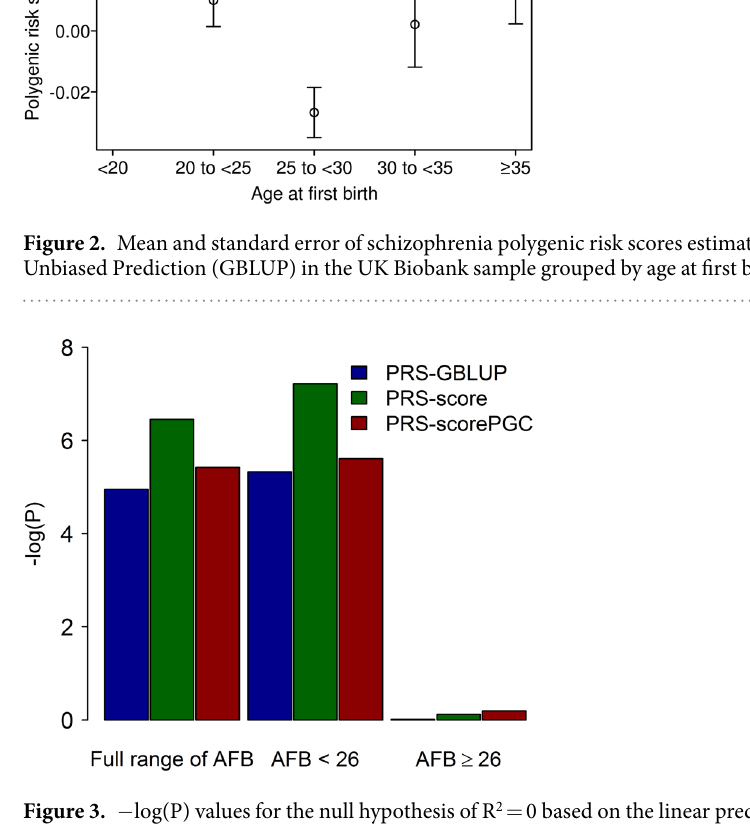
Figure 3. − log(P) values for the null hypothesis of R 2 = 0 based on the linear prediction. Full range of AFB: All available samples with a record of age at first birth were used. AFB < 26 ( ≥ 26): Analyses were only focus on samples with AFB < 26 ( ≥ 26). PRS-GBLUP: Schizophrenia (SCZ) polygenic risk scores estimated from genomic best linear unbiased prediction were used as an explanatory variable in the model. PRS-score: SCZ polygenic risk scores estimated from genome-wide association study based on available individual genotype data were used as an explanatory variable in the model. PRS-scorePGC: SCZ polygenic risk scores estimated from summary statistics results of full PGC SCZ GWAS study were used as an explanatory variable in the model. Response variables were generated with a polynomial function derived by Mehta et al . 17 , which describes the relationship between SCZ risk in offspring and maternal age (z = 2.7214 − 0.1105X + 0.0018X 2 , where X is age at first birth), and used in the model in which the AFB phenotypes were adjusted for age at interview, year of birth, assessment center at which participant consented, genotype batch, and the first 20 principal